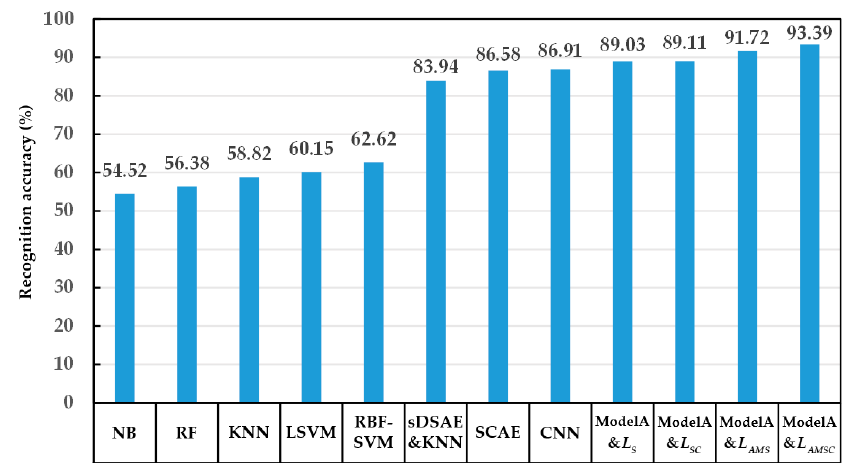
Figure 12. Recognition accuracy of different models when the dataset SNR is 5 dB.